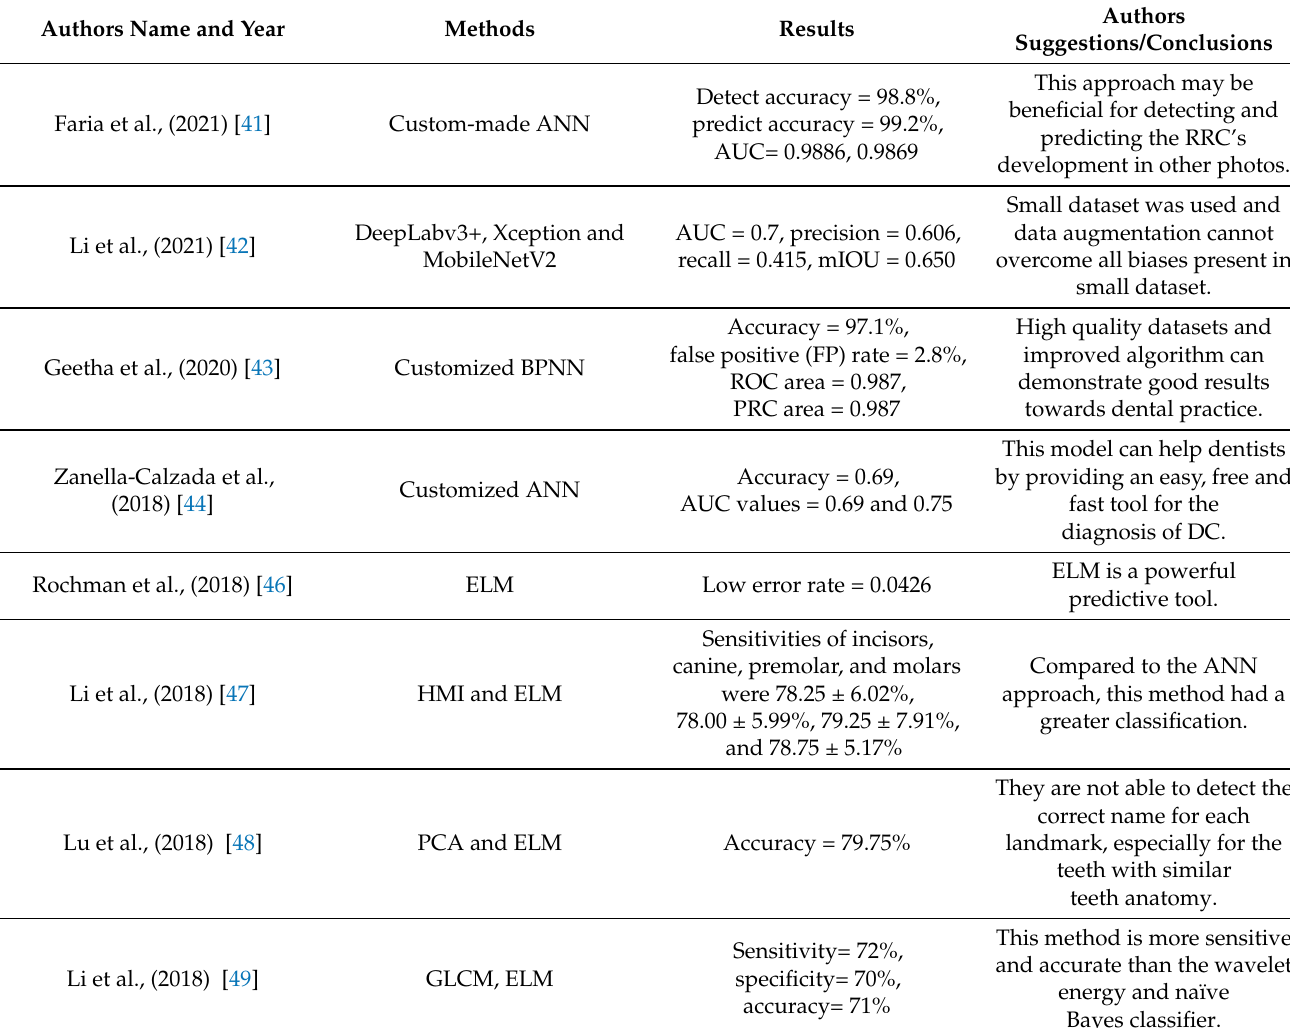
Table 3. ANN selected